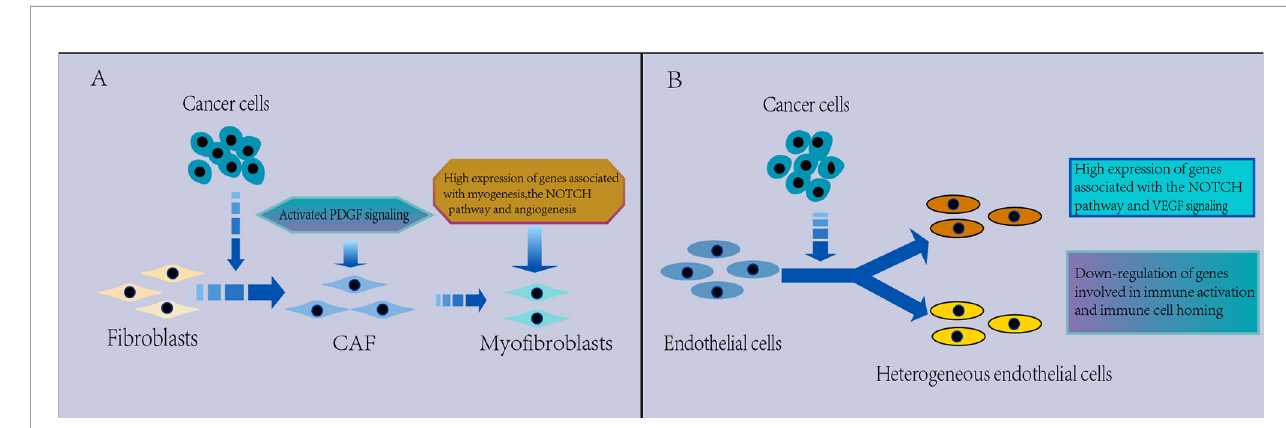
FIGURE 5 | (A) Characterization of CAFs in the TME. CAFs are heterogeneous. Myo fi broblasts were found to replace fi broblasts in the TME, which have a protumorigenic effect, with high expression of genes related to myogenesis, the Notch pathway and angiogenesis, and PDGF signaling is activated in the TME, which may be associated with the promotion of angiogenesis. (B) Characterization of ECs in the TME. The EC phenotype changes in the TME and appears signi fi cantly heterogeneous, which leads to tumor immunity toward immunosuppression. There is a strong activation of VEGF and Notch signaling that regulates EC development in NSCLC and downregulated expression of genes involved in immune activation and immune cell homing in tumor ECs, thus contributing to tumor